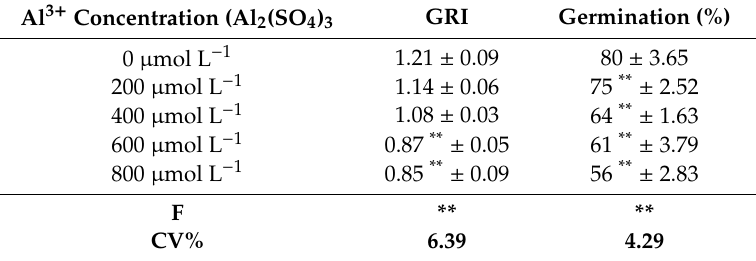
Table 1. Germination rate index (GRI) and germination percentage (%) in Eugenia dysenterica seeds after the application of a liquid calcium chloride solution containing di ff erent Al doses (0, 200, 400, 600 and 800 µ mol L − 1